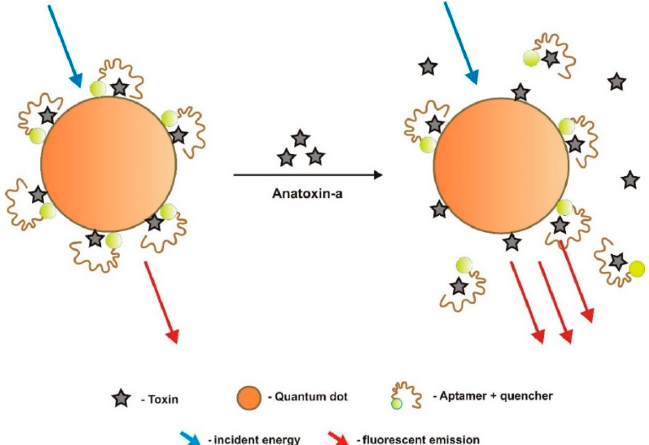
Figure 1. Schematic of the design strategy for the optical fluorescent resonance energy transfer (FRET) competitive binding assay developed by Jackson et al. [61], to detect anatoxin-a (ATX-A), based on quantum dot nanocrystals with ATX-A bound on their surface, and aptamers to ATX-A conjugated with quenchers of QDs